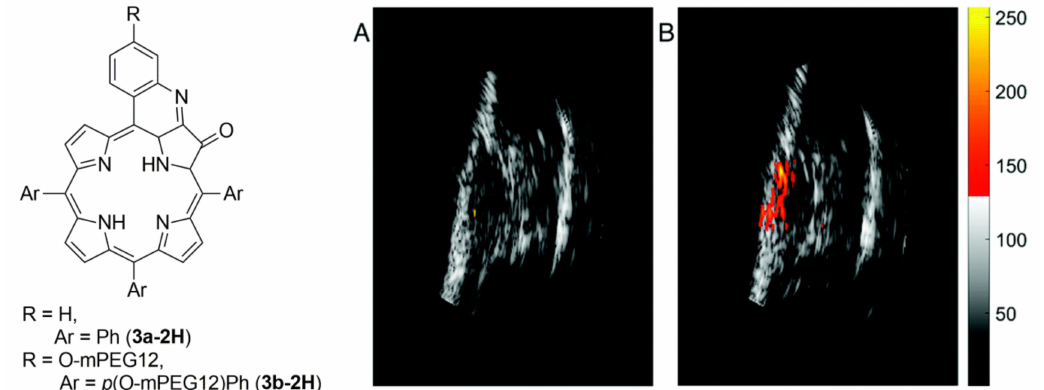
Figure 4. Left: Structure of NIR-absorbing β -,meso- quinoline-annulated porphyrin; right: photoacoustic images with PEGylated derivatives ( 3b-2H ) ( A ) before and ( B ) after 10-min injection of 3.33 µ mol / mL 3b-2H in a mice inoculated with tumor (the red zone contained PA probe, and Z-axis scales are arbitrary units). Reproduced from Reference [69] with permission from the Royal Society of